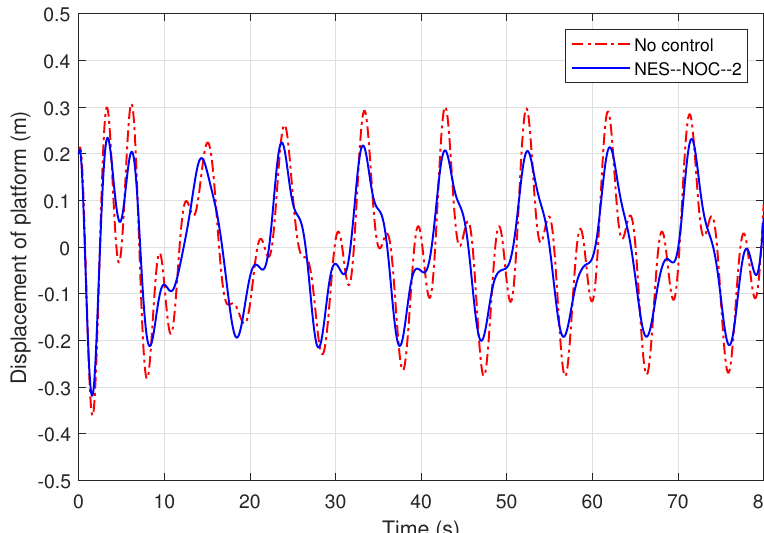
Figure 10. Displacements of the structure with